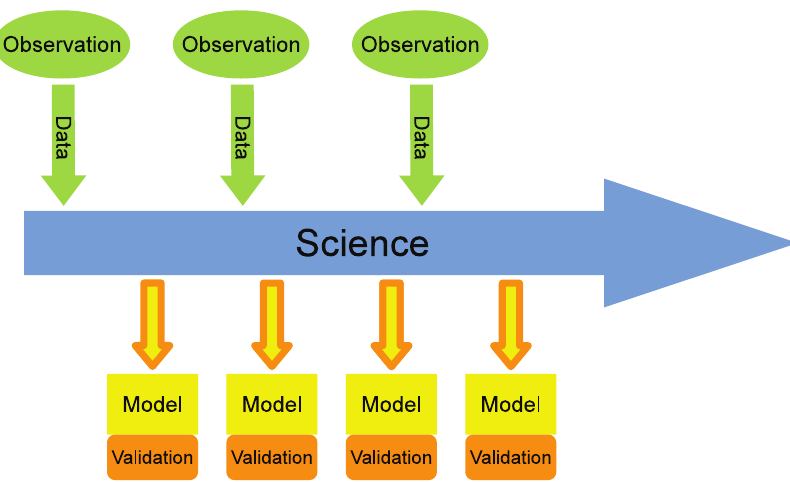
Figure 1. A scheme of the process of scientific research. The main input is data from observations, the main output are models with associated domains of